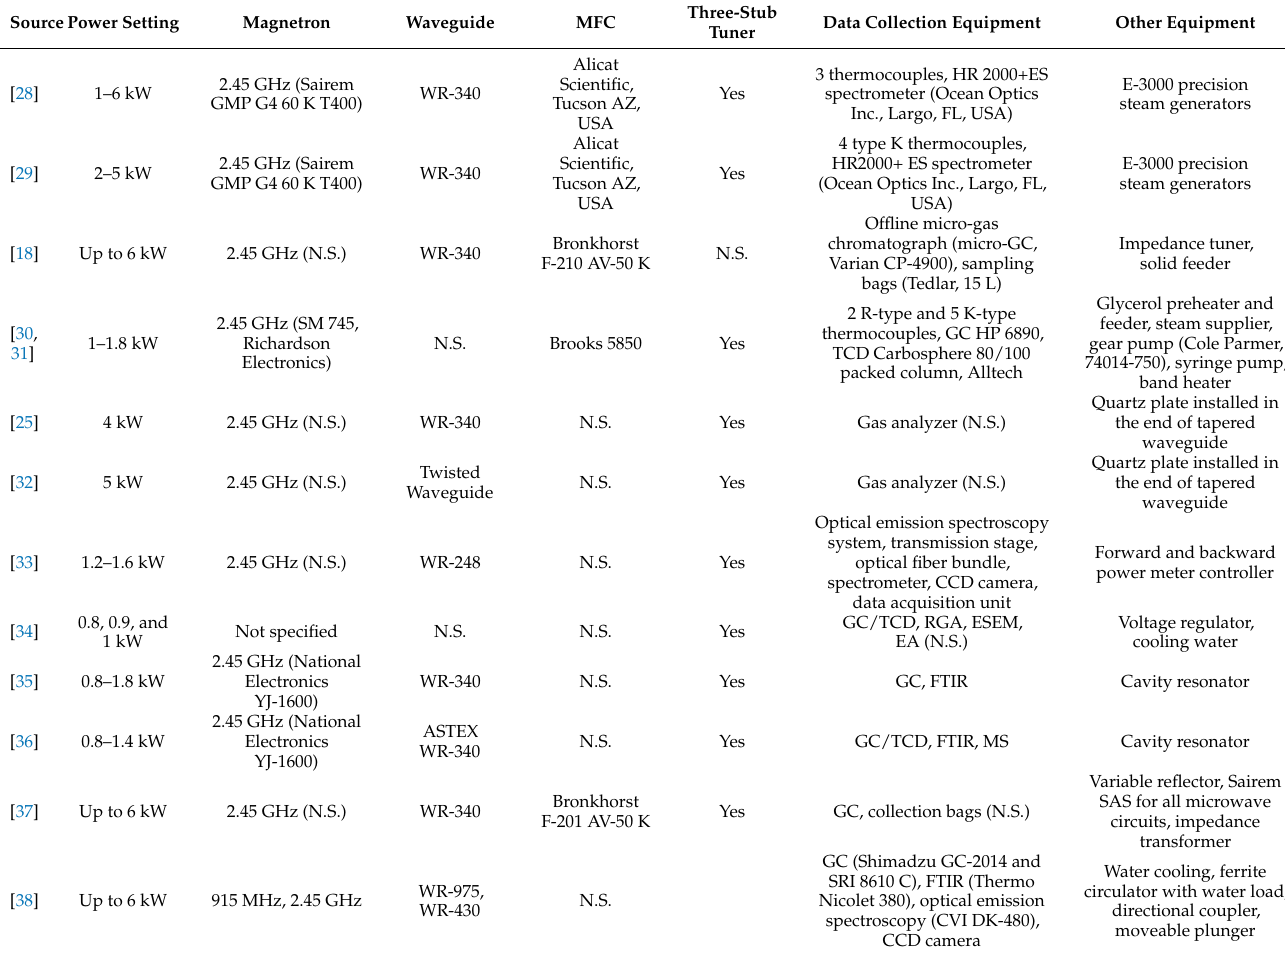
Table 2. Major components of experimental MIPG